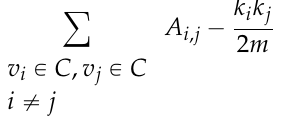
Figure 1. Example to illustrate the calculation of the neighborhood overlap score and identification of weak ties.